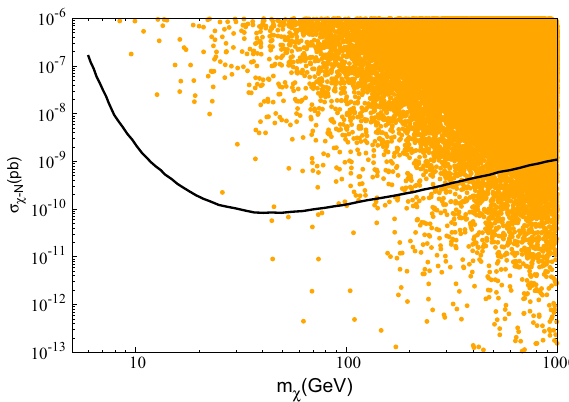
Fig. 5 Parameter space (yellow points) allowed by the relic density observation. The black line is the upper limit on the spin-independent χ − N scattering cross-section from XENON1T experiment. Region below the black line is allowed by direct detection bound from the XENON1T experiment. For this plot, we varied λ (cid:4)χ in the full range − 4 π to 4 π , 5GeV < m χ < 1 TeV, 4 TeV < (cid:7) < 50 TeV, f